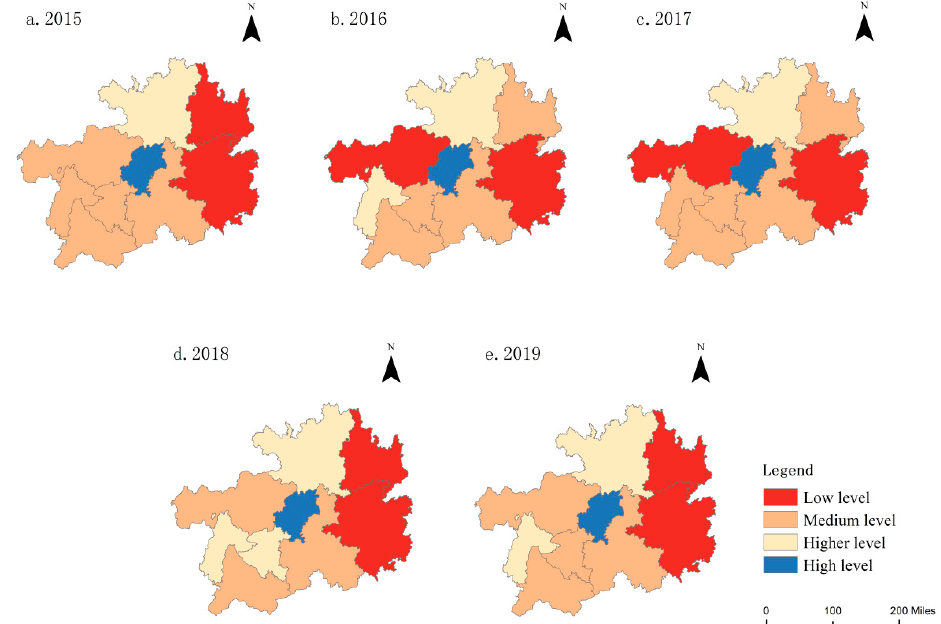
Figure 4. Spatial distribution of the high-quality development in Guizhou from 2015 to 2019. In general, Guizhou’s innovation, coordination, green, open, and development sub- systems are still in the grinding-in stage, failing to reach a benign resonance stage. Alt- hough the increase in most cities during the study period was small, the overall high- quality development system developed in an orderly manner. 3.3. Spatiotemporal Characteristics of Coupling Coordination Development between Ecological Protection and High-Quality Development in Guizhou 3.3.1. Development Process In terms of sequential variation, the coupling coordination degree between ecological protection and high-quality development in Guizhou showed a continuous growth trend, from 0.42 in 2015 to 0.6 in 2019. In addition, Guizhou has developed from a near-disorder degree to a primary coordination degree. At the regional level, the coupling coordination degrees of Guiyang, Bijie, Tongren, Qiandongnan, Qiannan, and Qianxinan showed a steady growth trend. Guiyang had the largest increase (79%), which reached the level of primary coordination. Anshun and Liupanshui showed a trend of volatile growth and reached the level of reluctant coordination in 2019. During this five-year period, Gui- zhou’s level of coupling coordination grew steadily as it utilized high-quality ecological resources to develop characteristic green industries, and it continues to increase financial investment and policy subsidies. The coupling coordination degree of Zunyi showed a downward trend of fluctuation, from 0.72 in 2019 to 0.69 in 2015. Although the decline is small, a cautious approach is required. It is necessary to take measures to improve coor- dination and maintain an internal balance between ecological protection and high-quality development. The type of coupling relation in most cities has changed, and the speed is fast, which indicates that these cities have preliminarily established a coupling develop- ment between ecological protection and high-quality development.